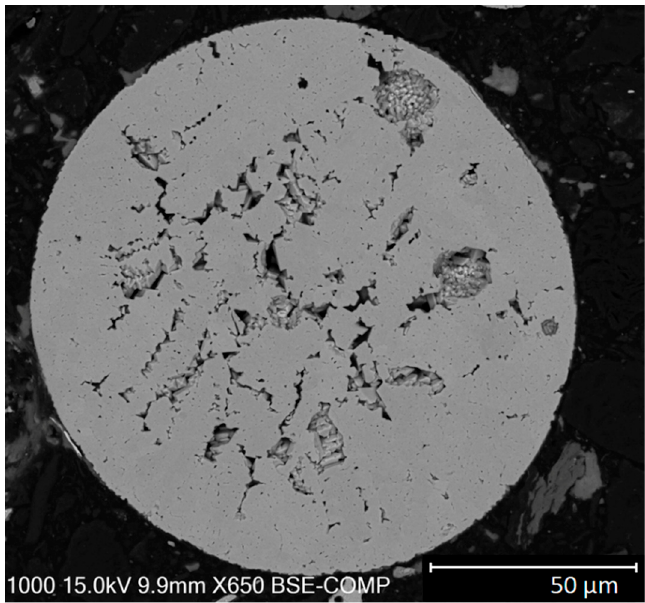
Figure 9. Microparticle cross-section observed in a backscattered electrons mode.